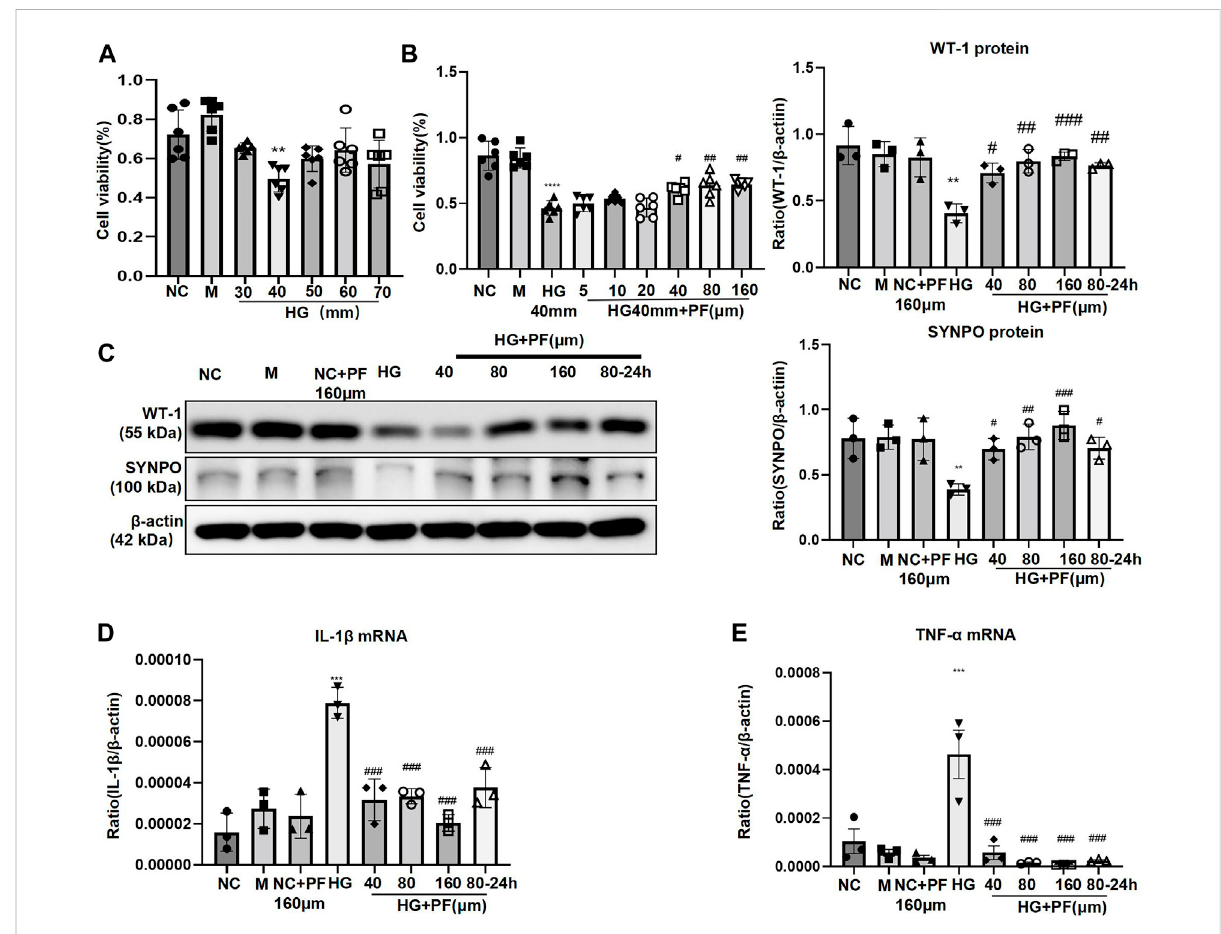
FIGURE 5 PF ameliorates HG-stimulated podocyte injury. (A) MTT assay to evaluate the effect of HG on MPC5 cells viability. (B) MTT assay to evaluate the effect of PF on HG-stimulated MPC5 cells viability. (C) WB assay of WT-1 and SYNPO protein in MPC5 cells. (D) IL-1 β mRNA in MPC5 cells. (E) TNF- α mRNAinMPC5cells. Resultsrepresentthemean±SD.** p < 0.01,*** p < 0.001 vs.NC; # p < 0.05, ## p < 0.01, ### p < 0.001 vs.HG.NC,normalcontrol (5.5 mmol/Lglucose);HG,highglucose(40 mmol/L);M,mannitol(34.5 mmol/Lmannitol+5.5 mmol/Lglucose);PF,paeoni fl orin;WT-1,Wilms tumor 1 protein; SYNPO, synaptopodin; WB, Western blotting; MPC5, mouse podocyte clone 5; TNF- α , tumor necrosis factor- α